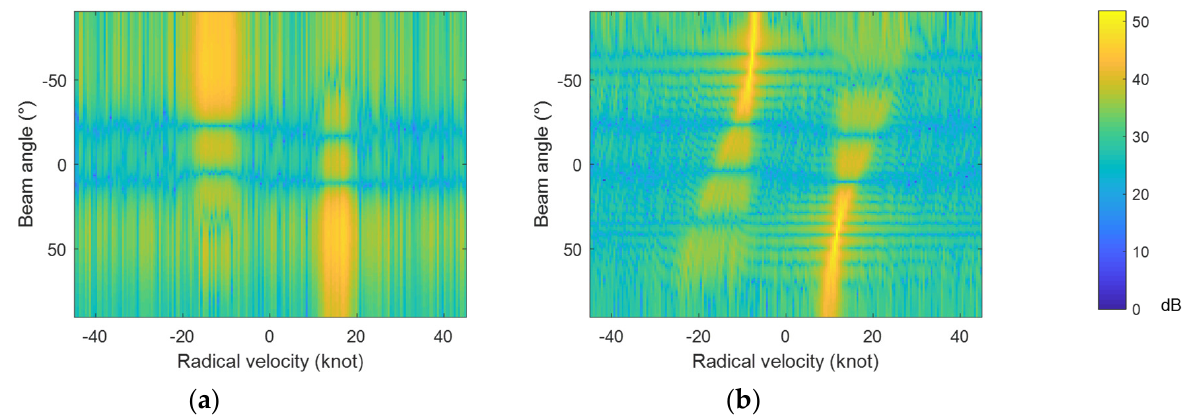
Figure 12. Compensation result for the case of uniform deceleration motion: ( a ) compensation result for angle1, ( b ) compensation result for angle2.